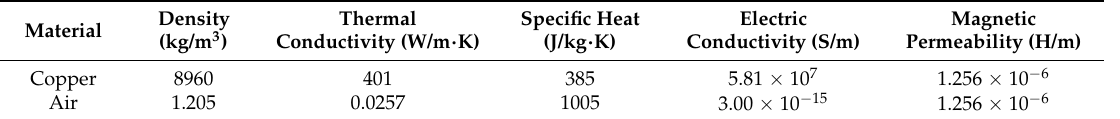
Table 1. Properties of copper and air for electromagnetic and thermal analyses.